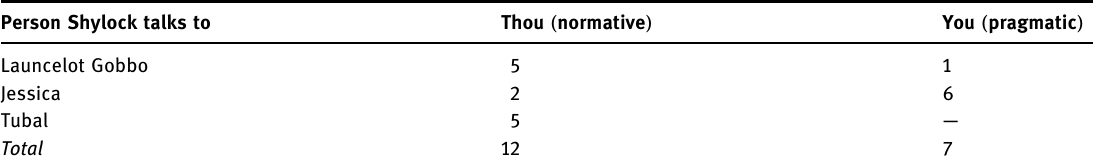
Table 4: Frequencies of normative thou and pragmatic you Person Shylock talks